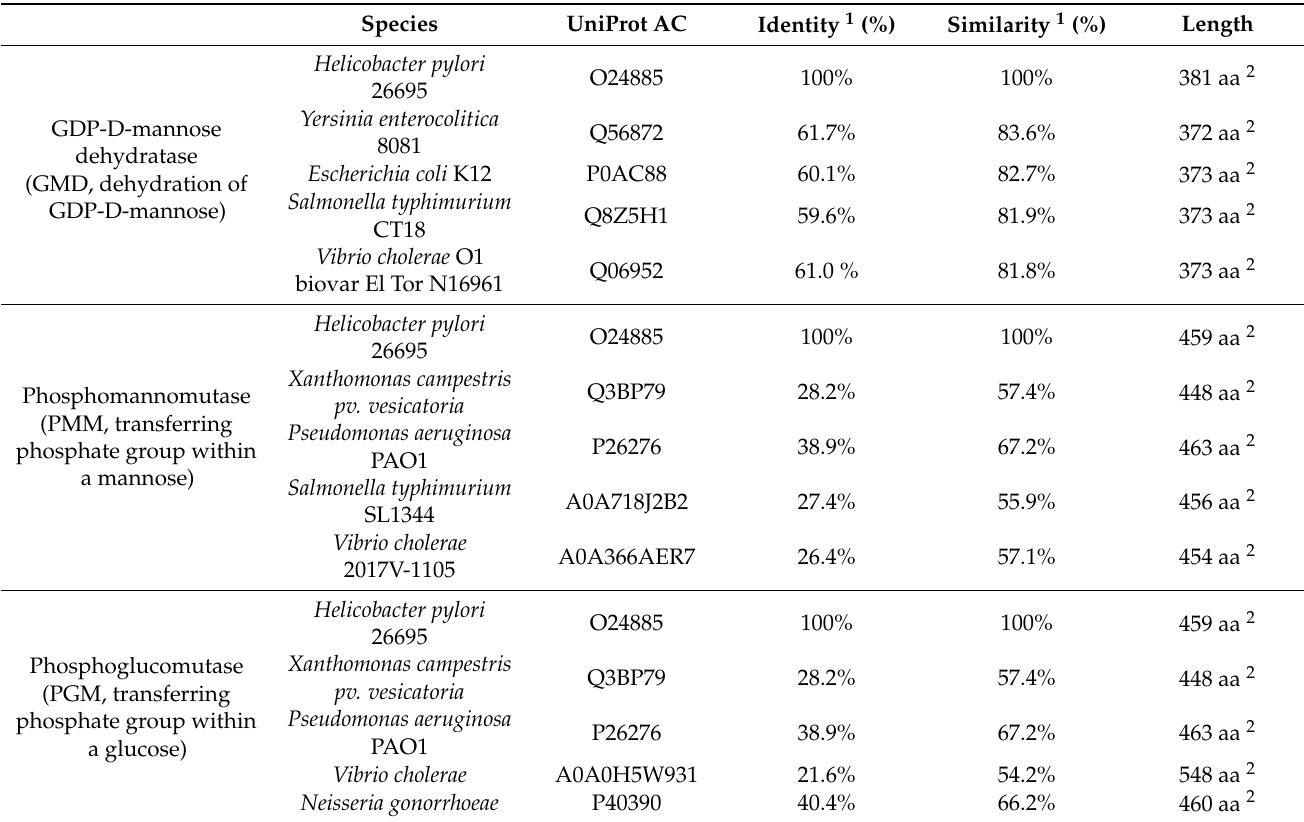
Table 3. Sequence comparison of the HP0044 protein and HP1275 protein from H. pylori wild-type strain 26695 with corresponding homologues from other Gram-negative bacteria. Species UniProt AC Similarity 1